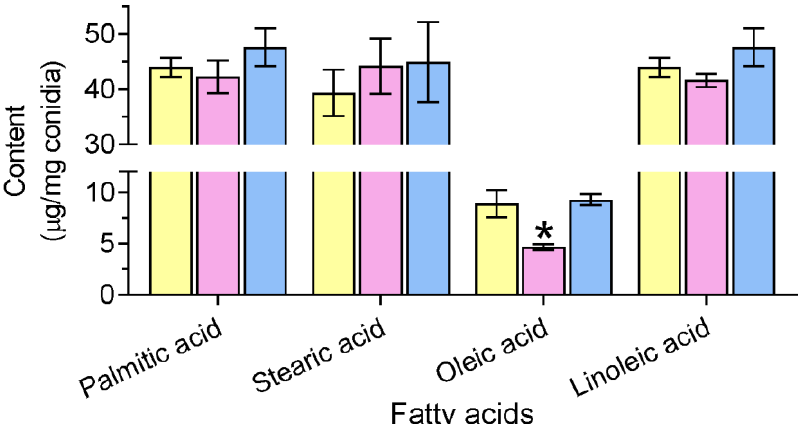
Figure 1. Fatty acid content in the B. bassiana conidia. The indicated strain was cultured on SDAY plates for 8 d, and the levels of fatty acids were determined in the conidia. The B. bassiana conidia accumulated four free fatty acids (stearic, palmitic, oleic, and linoleic acid) in the conidia. The gene disruption of BbSAY1 led to a significant decrease in the level of oleic acid. The asterisk on the column indicates the significant difference in the fatty acid content between the ∆ Bbsay1 and the wild-type or complemented strains (Tukey’s HSD: p <0.05). Error bars: standard deviation.